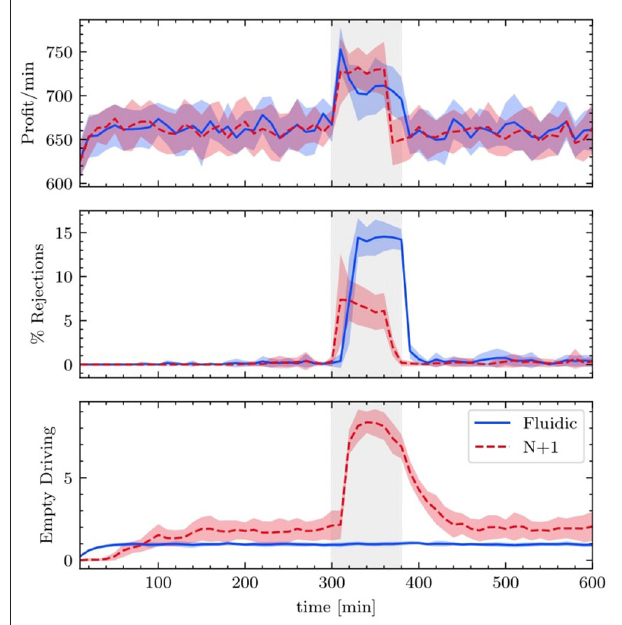
FIGURE 8 | Responsiveness of the dynamic policy vs. a static policy. Between minutes 300 to 380 (shaded region) we have perturbed the demand of a single region by multiplying it by a factor of three. We observe in the two lower plots how the real time controller N+1 responds to this by sending more vehicles to these region compared with the static fluidic controller. As a result, N+1 provides a better service as the number of customer rejections is lower compared to the fluidic